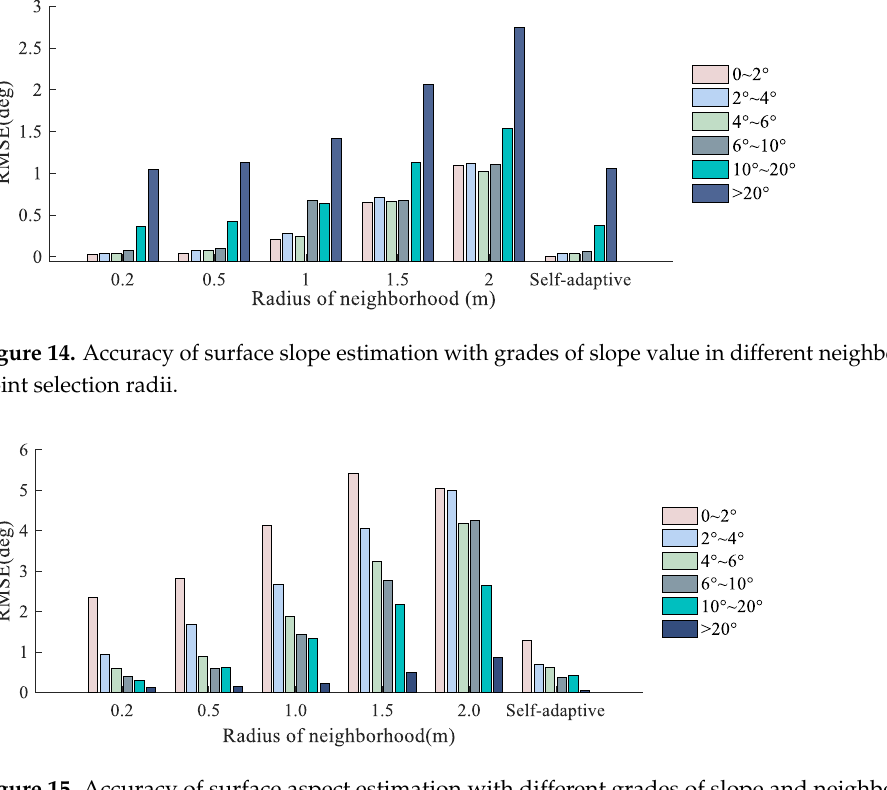
Figure 15. Accuracy of surface aspect estimation with different grades of slope and neighborhood point selection radii. Table 6. Root mean square error of wave surface aspect estimation in different intervals. Table 5. Root mean square error of wave surface slope estimation in different intervals. Radius